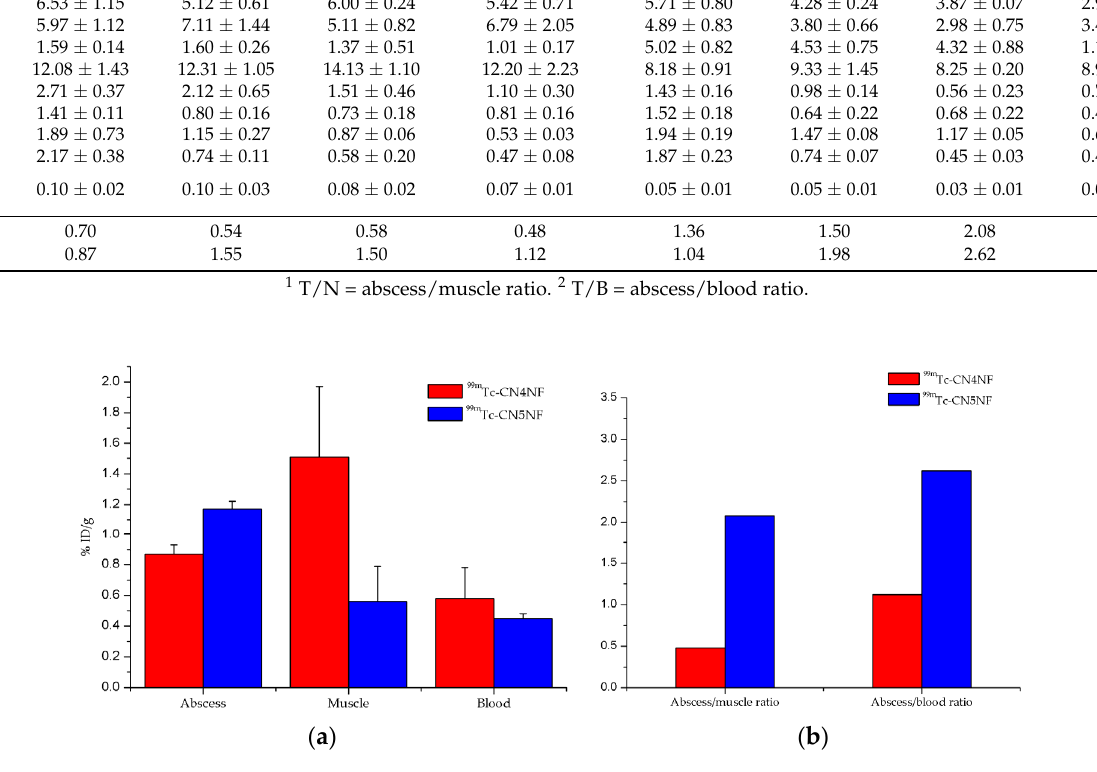
Mice with Turpentine- Mice with Bacterial Infection Mice with Bacterial Infection For other organs, the low values of radioactivity uptake in the stomach and thyroid Induced Ab- indicated that the complexes had good stability in vivo. scess Table 1. Biodistribution of [ 99m Tc]Tc-CN4NF and [ 99m Tc]Tc-CN5NF in mice (% ID/g ± SD, n = 4).